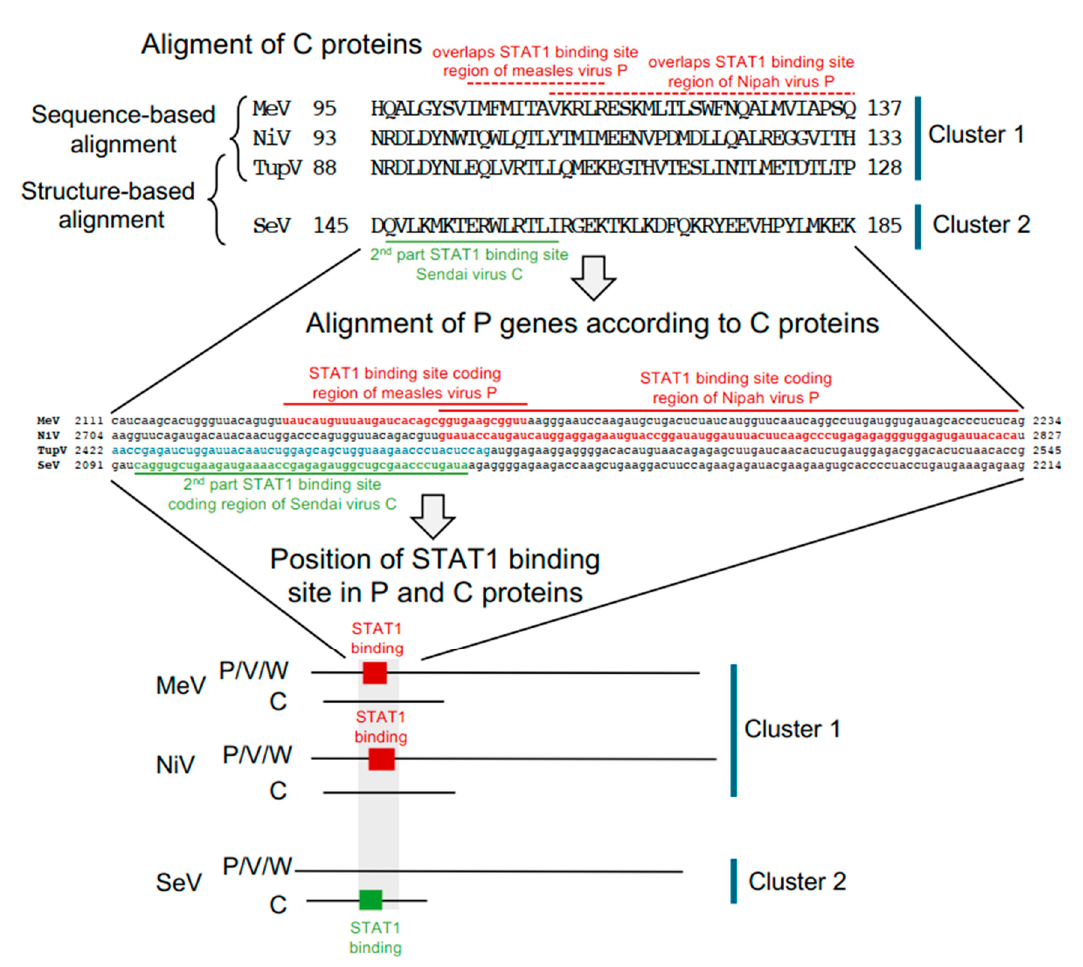
Figure 11. Position of the STAT1 binding site in Orthoparamyxovirinae P or C proteins . The upper panel of the figure shows the alignment of the part of the C proteins encompassing helices D and E of TupV C for members of both clusters. The sequence alignment of MeV, NiV, and TupV C is taken from [22], and SeV C is aligned on the TupV C sequence according to the structural alignment shown in Figure 4D. This alignment is converted into a nucleotide alignment (middle panel), where the regions coding for the STAT1 binding site are highlighted in red (encoded in the reference frame in MeV and NiV) or in green (encoded in the +1 frame in SeV). The lower panel is a schematic representation of the proteins expressed from the P gene, showing the location of the STAT1 binding site either in P/V/W proteins (cluster 1) or in C protein (cluster